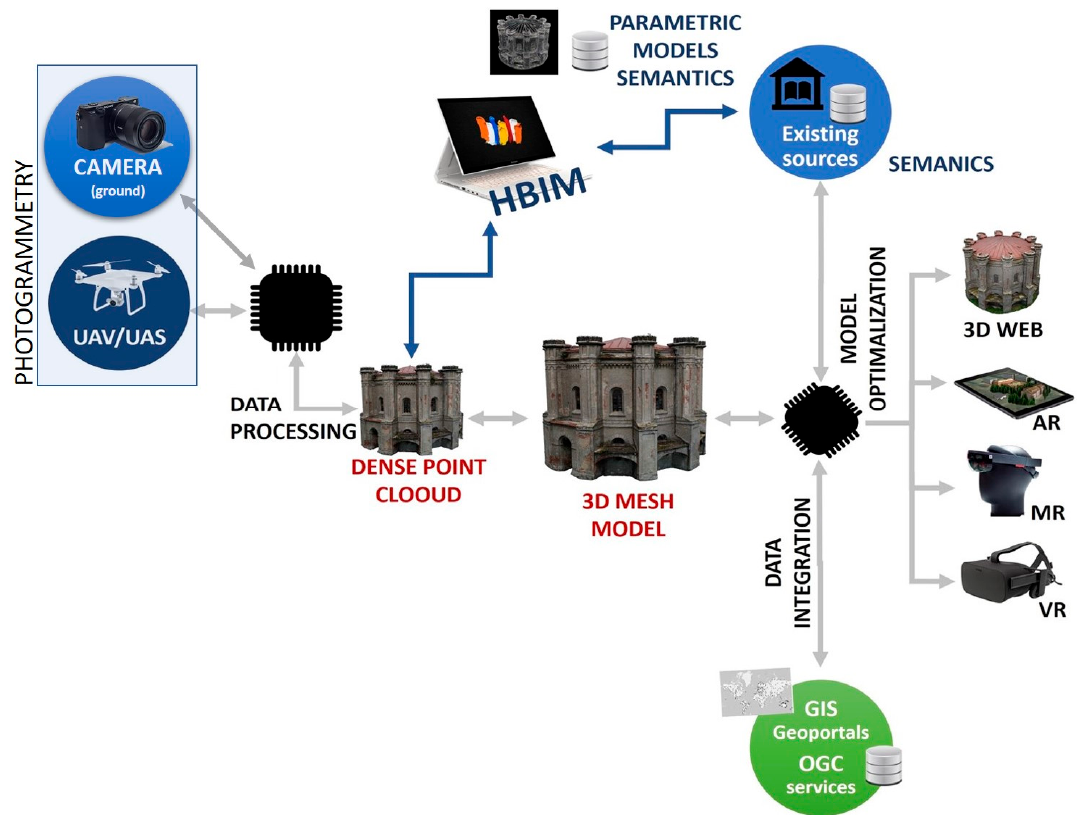
Figure 2. Review of the methodology adopted for the reconstruction of 3D buildings using UAV/UAS.